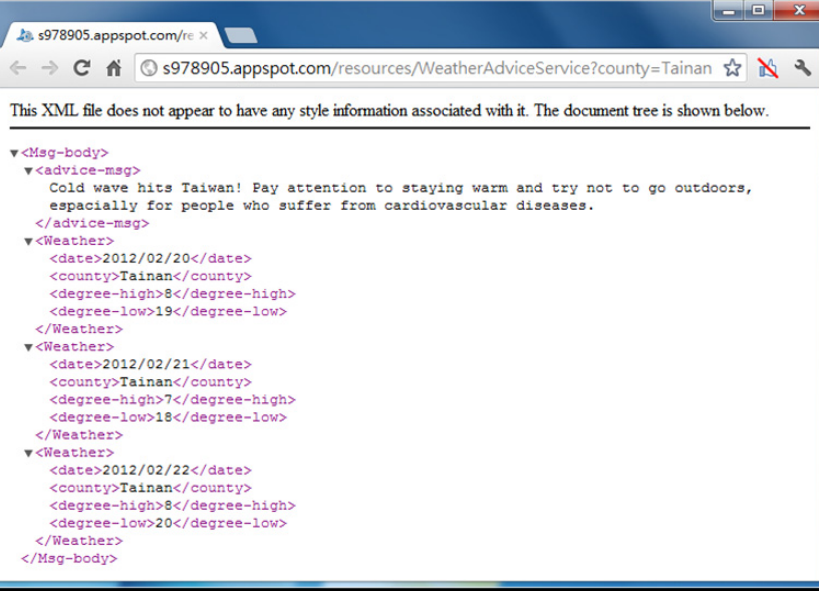
Figure 8. The sample Java code of accessing the “Weather Advice” web